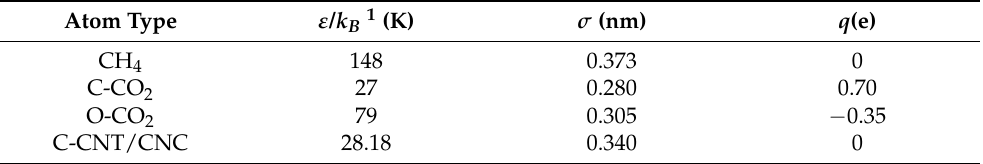
Table 1. Force field parameters for CH 4 , CO 2 , and C in CNTs or